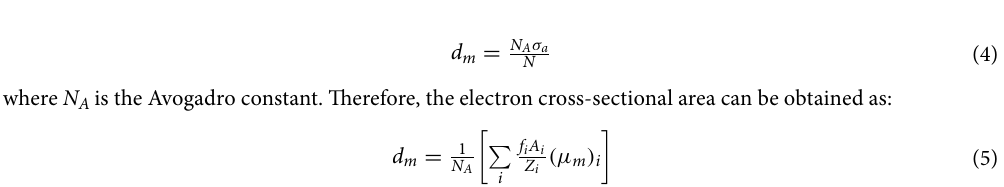
Figure 2. Enlarged structure of the morpho butterfly